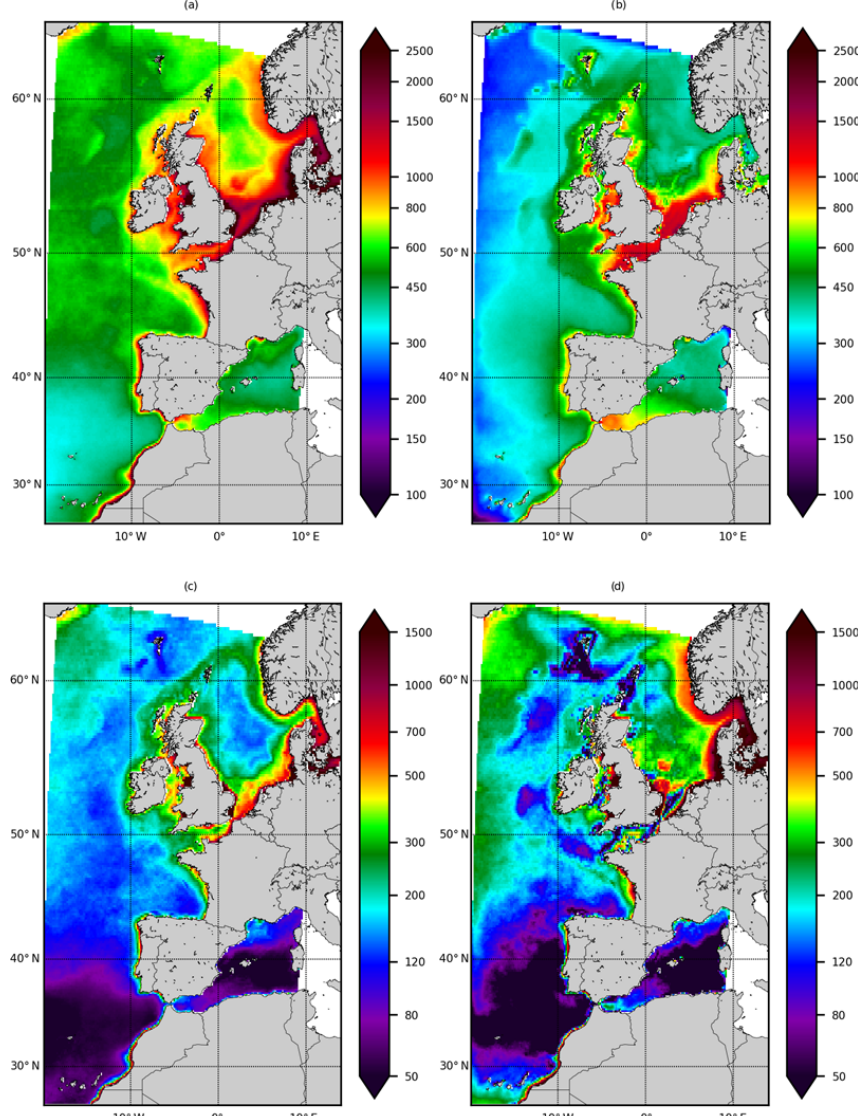
Figure 5. Depth-integrated NPP (mgCm − 2 d − 1 ). (a) Mean of the three NPP products (VGPM, Eppley-VGPM and CbPM), (b) IBI36, (c) standard deviation of the three NPP products and (d) bias (IBI36 − mean NPP poducts). Statistics are computed from monthly fields between 2010 and